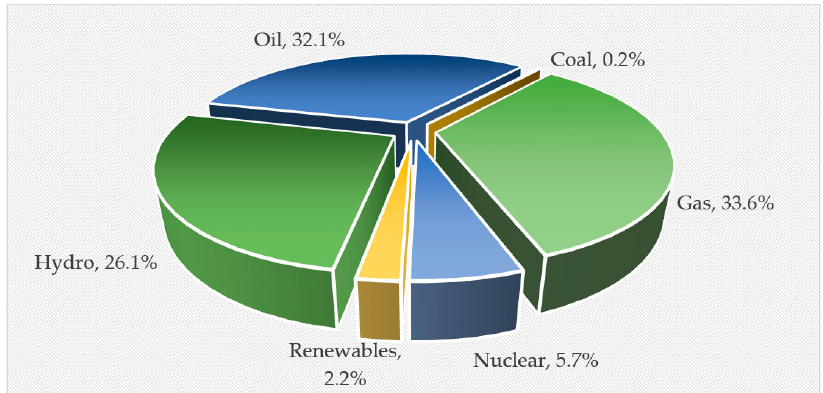
Figure 2. Energy mix of Pakistan.